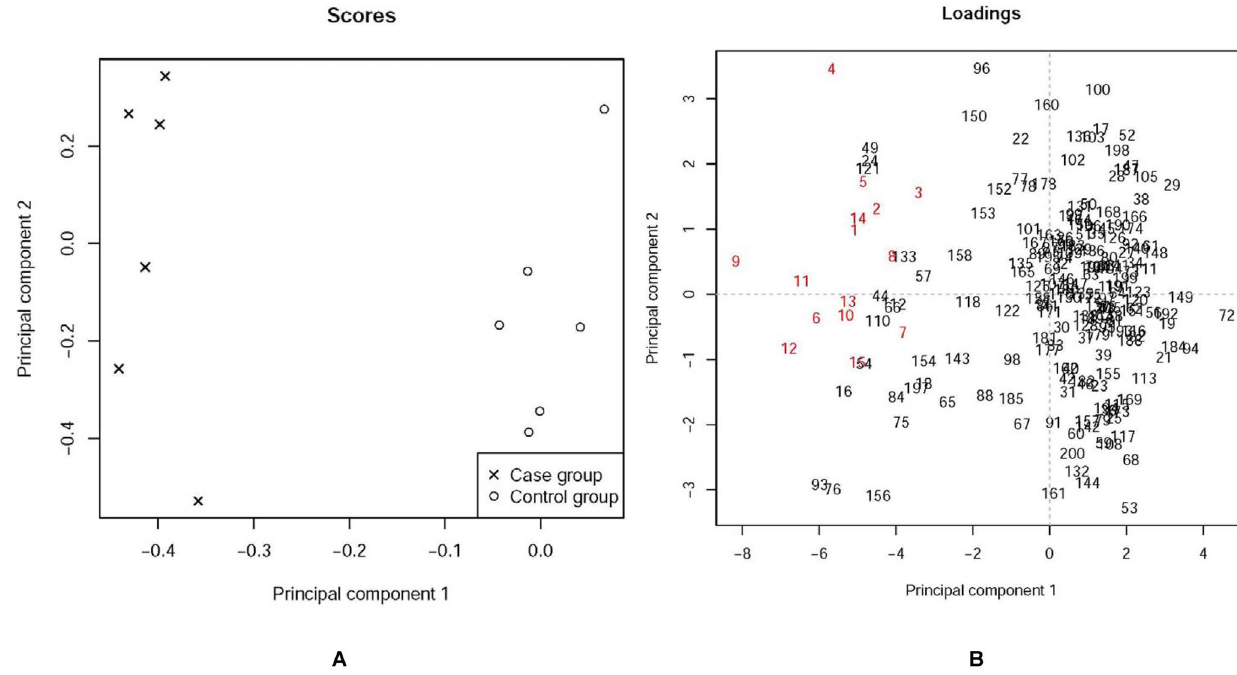
Figure 2. The PCA score plot and corresponding loading plot for the simulation data: (A) The score plot showing the separation between the Case group(X) and the Control group (o) (B) Loading plot for potential biomarker recognition. Metabolites 4, 6, 9, 11, and 12 are identified as potential biomarkers. Integers in red indicate biomarkers and integers in black indicate other markers.